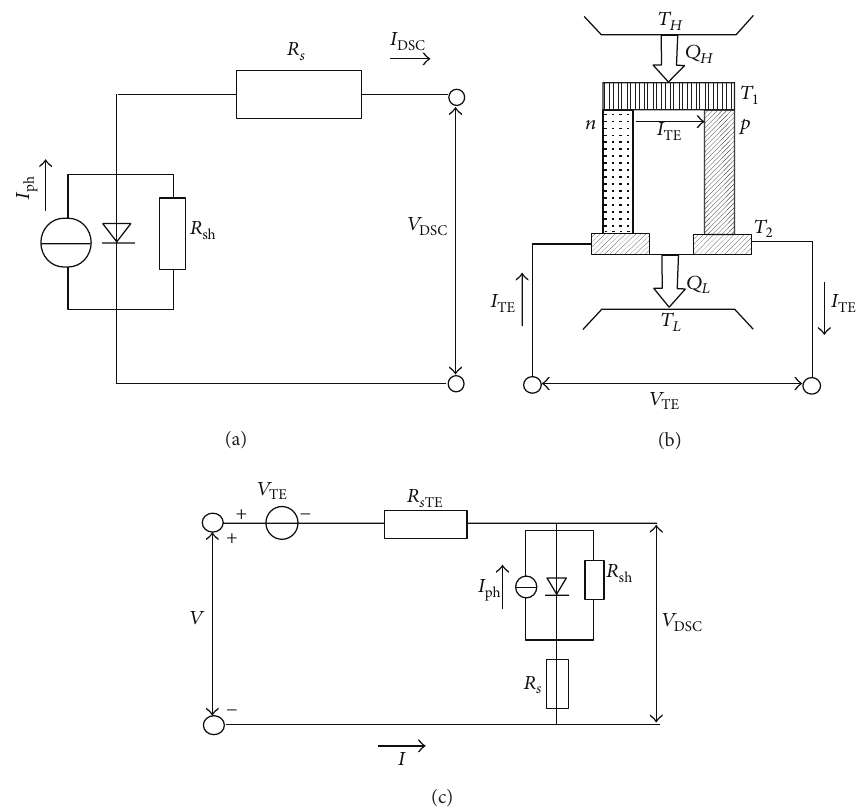
Figure 1: Equivalent circuit of (a) single DSSC, (b) single TE, (c) series DSSC, and TE hybrid